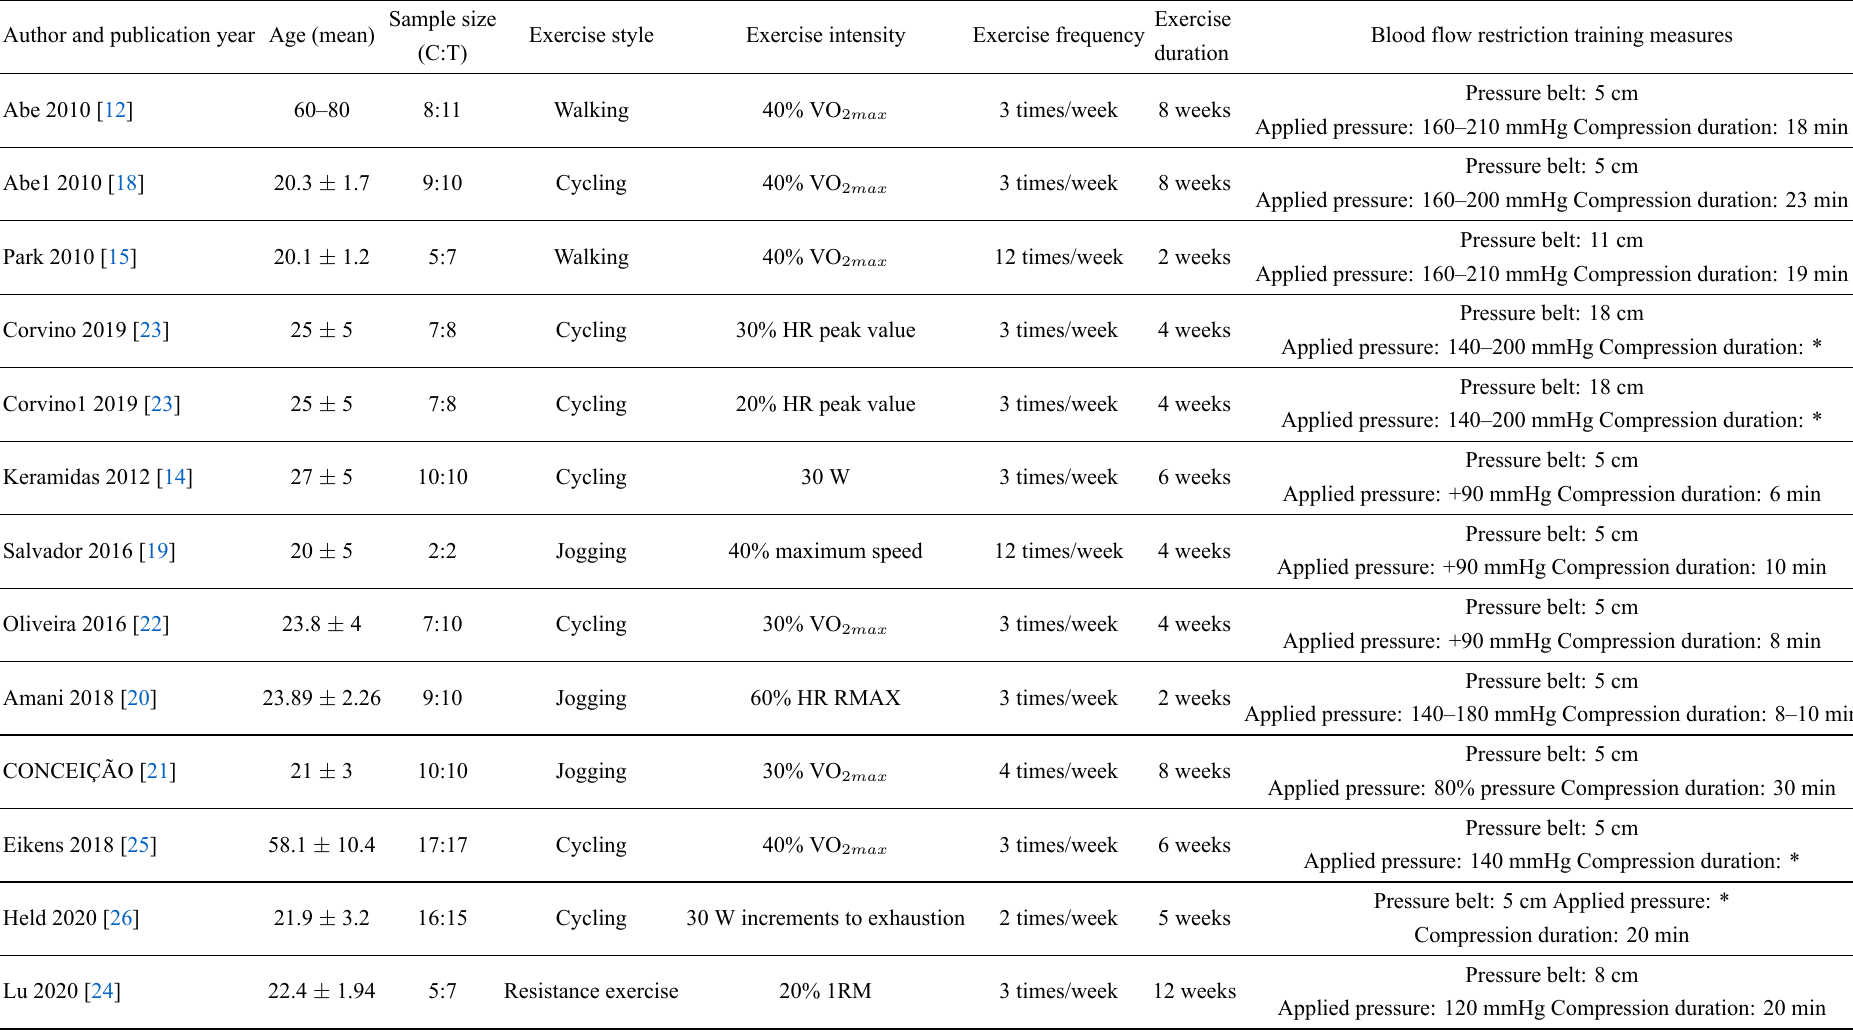
Table 1. List of basic characteristics of the included